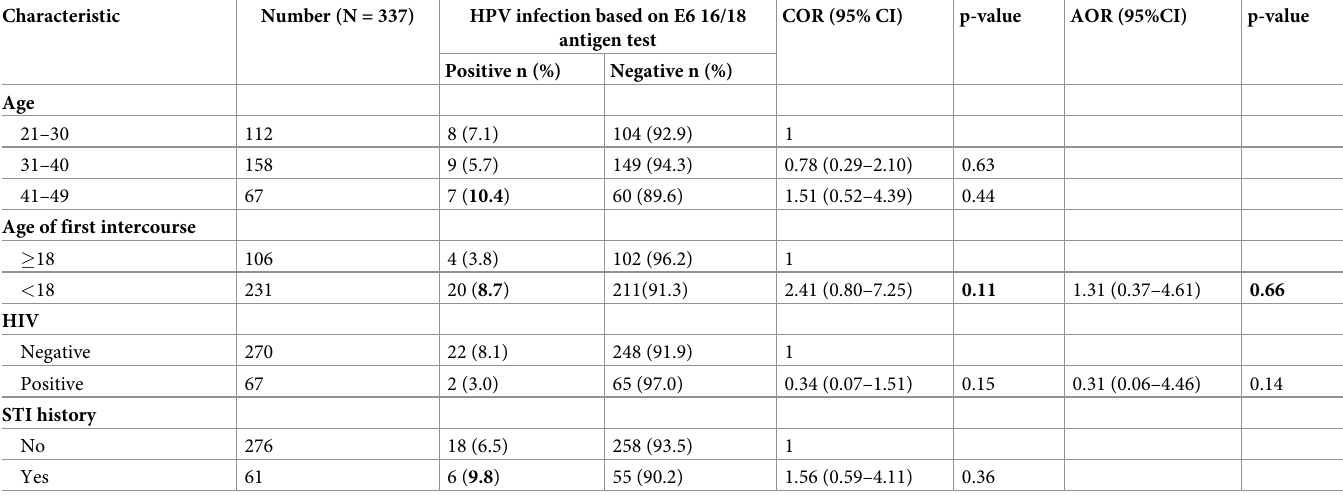
Table 5. Logistic regression analysis of HPV positivity among participant women (n = 337) aged 21–49 years, Amhara region, Ethiopia, 2019.